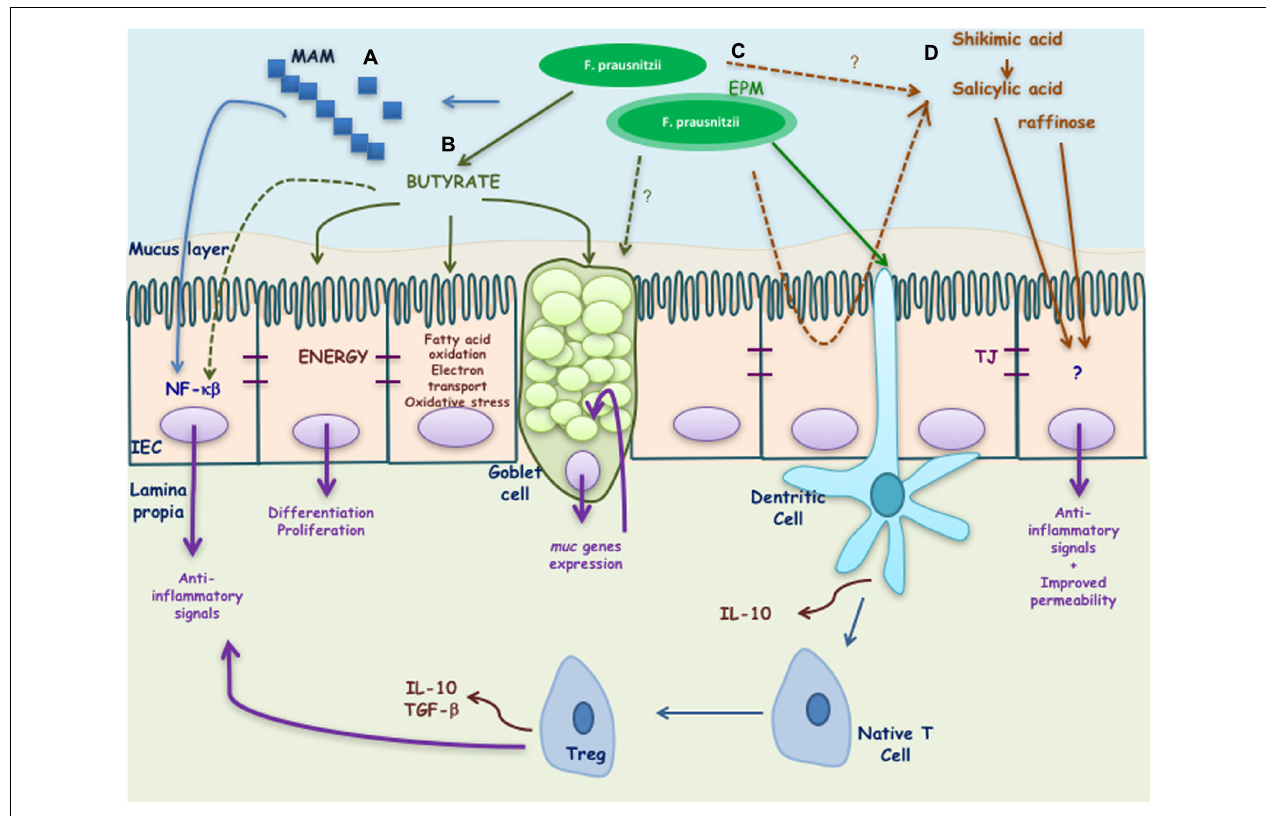
FIGURE 2 | Putative effectors of Faecalibacterium prausnitzii and its effects on the host. F. prausnitzii exerts its benefic effects by means of different effectors: (A) MAM peptides secreted by F. prausnitzii block NF- κ B activation induced by a pro-inflammatory stimulus. (B) Butyrate produced by F. prausnitzii inhibits NF- κ B activation and interacts with the intestinal epithelial cells (IEC) driving to the activation of different genes involved on the differentiation, proliferation, and restitution of enterocytes. It is also involved on the regulation of fatty acid oxidation, electrons transport chain, oxidative stress, and apoptosis. In goblet cells it has been described to stimulate muc genes allowing a high production of mucus. (C) EPM produced by F. prausnitzii modulates IL-10 cytokine production in antigen presenting cells. Finally, (D) salicylic and shikimic acids are anti-inflammatory molecules able to block inflammation induced by a pro-inflammatory stimulus while raffinose is key in maintaining gut